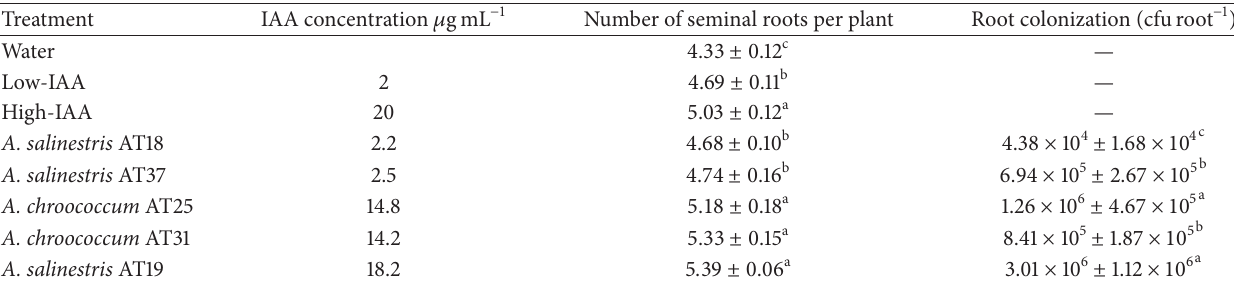
Table 3: Effect of pure IAA solutions and Azotobacter inoculation on the number of seminal roots, and root colonization of 8-day-old wheat